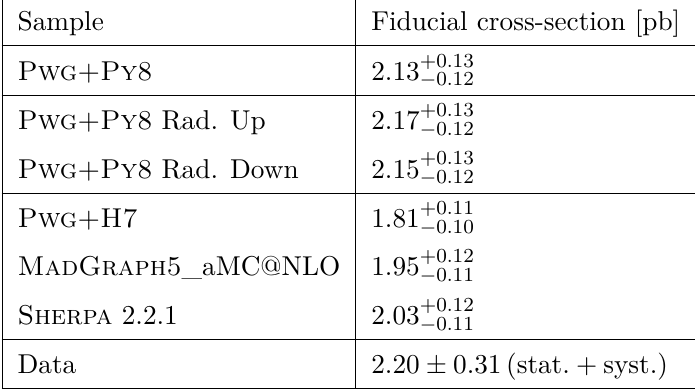
and α ) affecting the K -factor used in the t S